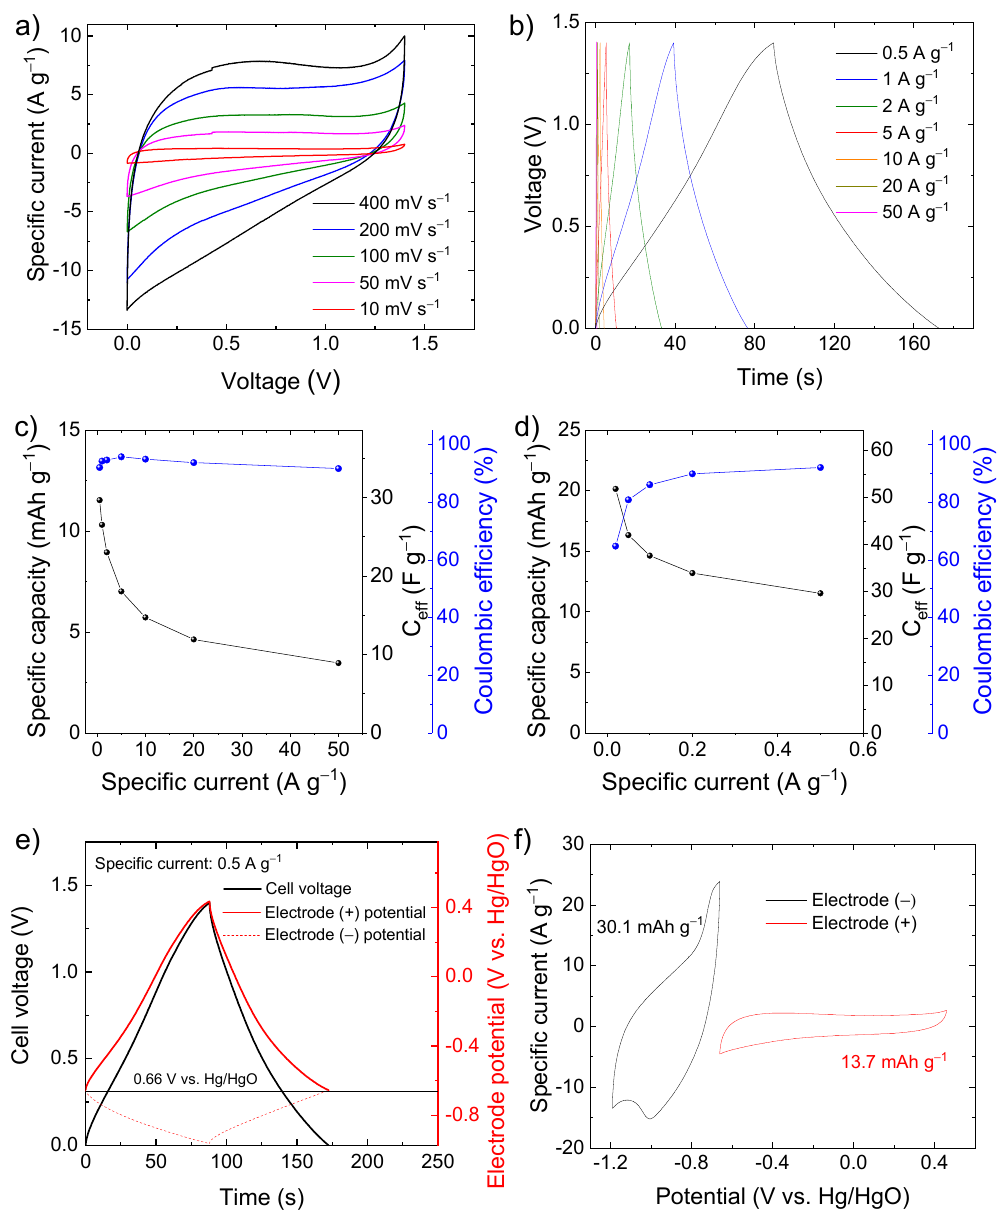
Figure 5. ( a ) CV curves of symmetric SC-based C-Fe 2 O 3 electrodes measured at different voltage scan rates (from 10 to 400 mV s − 1 ) in 6 M KOH; ( b ) galvanostatic CD curves of the same SC measured at different specific currents (from 0.5 to 50 A g − 1 ); ( c ) capacity, C eff , and CE of the symmetric SC as a function of the specific current, ranging from 0.5 to 50 A g − 1 ; ( d ) capacity, C eff , and CE of the sym- metric SC measured at low specific currents (from 0.02 to 0.5 A g − 1 ); ( e ) galvanostatic CD curve of the symmetric SC measured at specific current of 0.5 A g − 1 and the corresponding galvanostatic CD curves measured for the negative and positive electrodes (named electrode ( − ) and electrode (+), respectively) in a three-electrode cell configuration by means of a reference electrode; ( f ) CV curves measured for our positive and negative electrodes in a three-electrode cell configuration. The max- imum and minimum potential vertexes of the negative and positive electrodes, respectively, were set nearby the PZV of the electrodes in the symmetric SC (between 0.6 and 0.7 V vs. Hg/HgO). To solve the limitations of the symmetric SC, the capacities of the electrodes were balanced by adjusting the mass loading of the active material according to Equation (7), assuming the specific capacity calculated from the CV curves of the electrodes of the sym- metric SC, i.e., 30.1 mAh g − 1 for the negative electrode and 13.7 mAh g − 1 for the positive electrode (see Figure 5f). Since the electrodes are made of the same chemical composition,